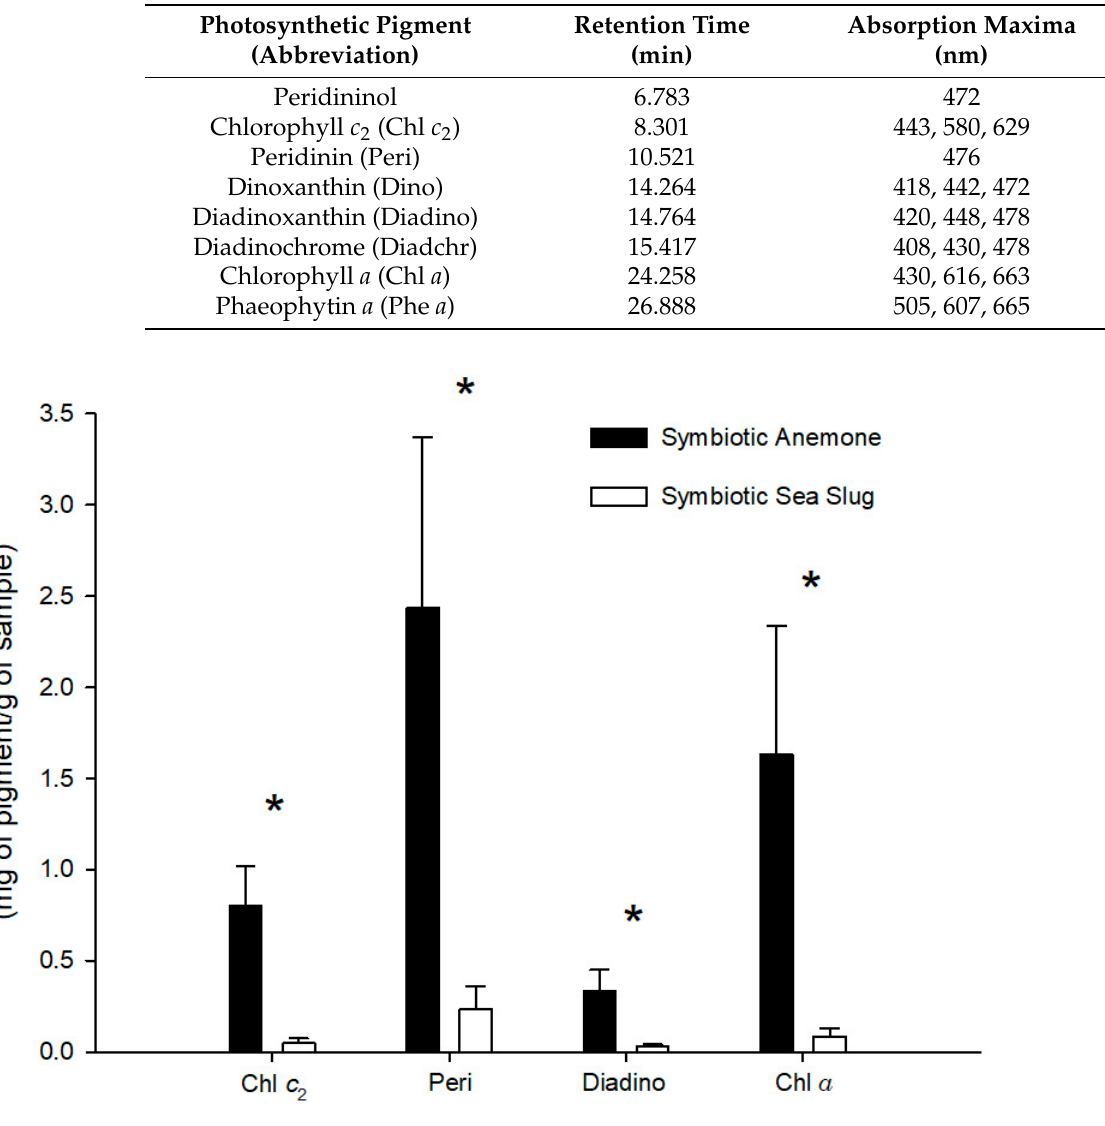
Table 1. List of photosynthetic pigments recorded in Berghia stephanieae and Exaiptasia diaphana with retention times and absorption maxima.